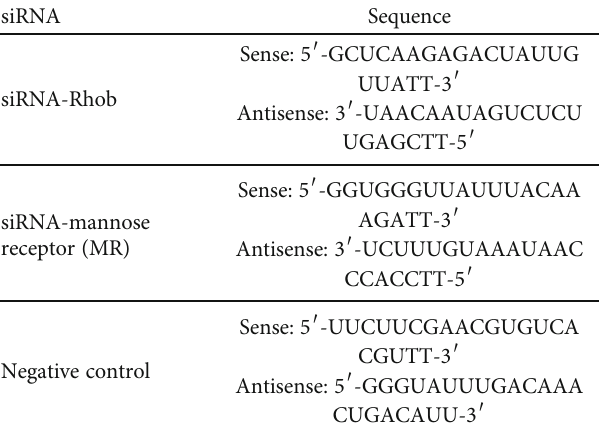
Table 2: Sequence of